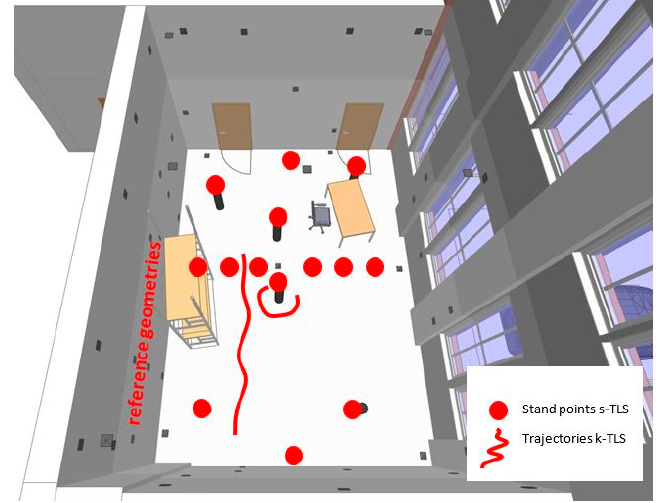
Figure 14. Trajectories of k-TLS and stand points for s-TLS.